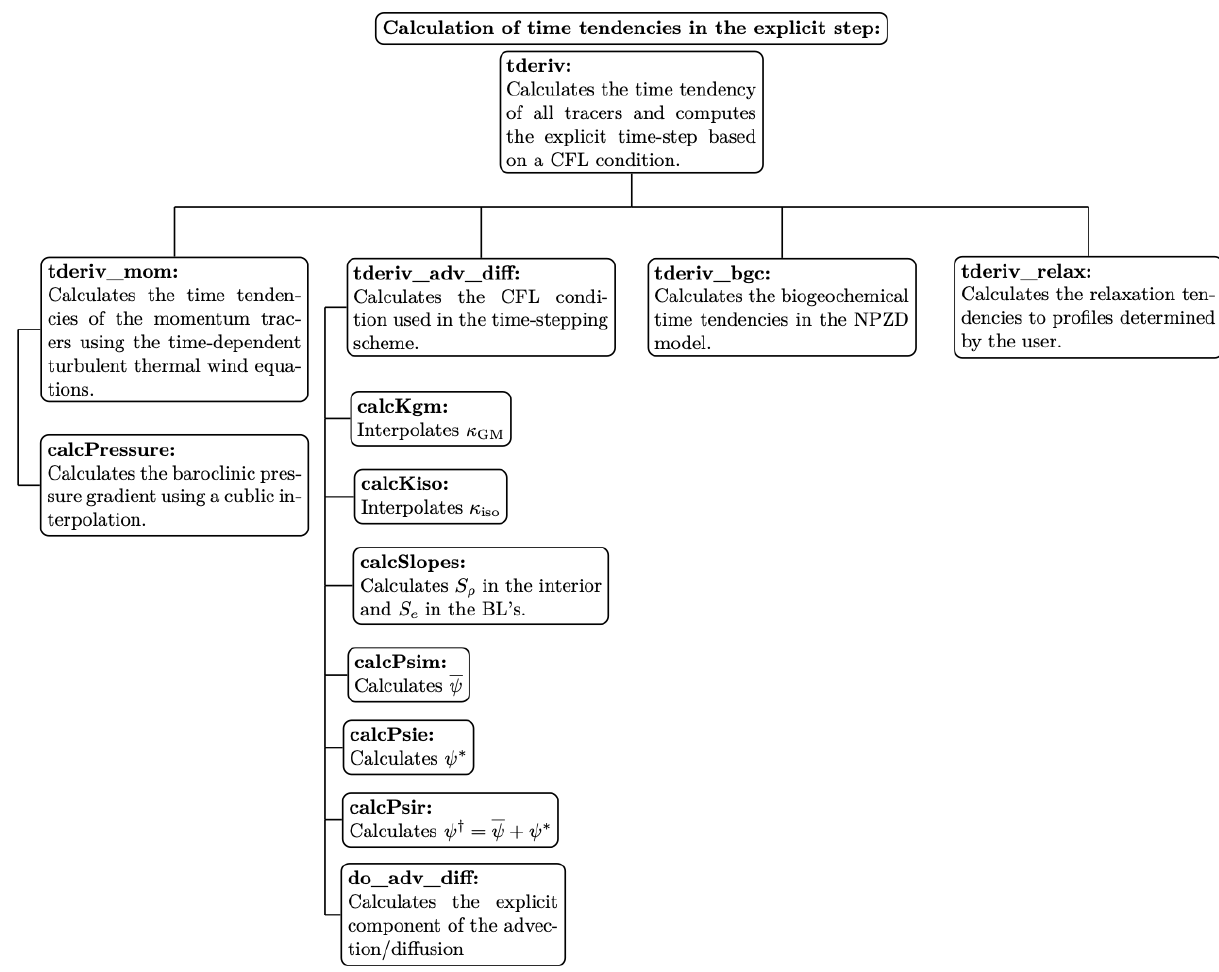
Figure 4. The call tree from the main function of